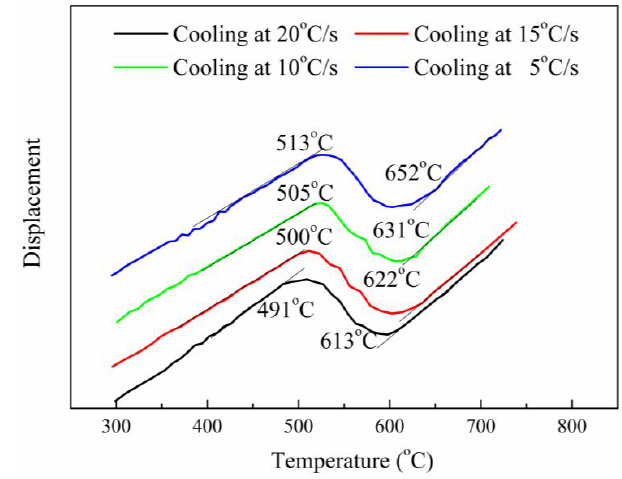
Figure 10. Dilatation curves and Ar 3 and Ar 1 points for samples cooling at different rates.